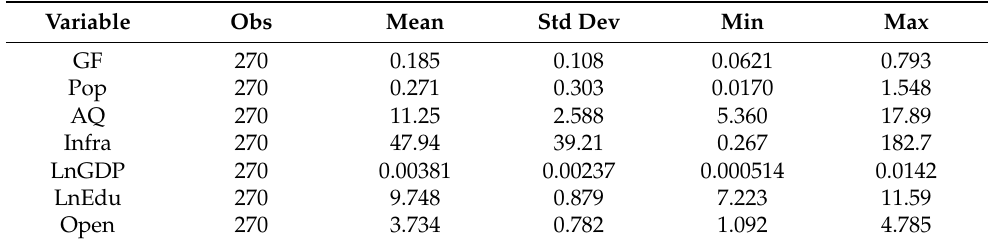
Table 3. Variables’ descriptive statistics.